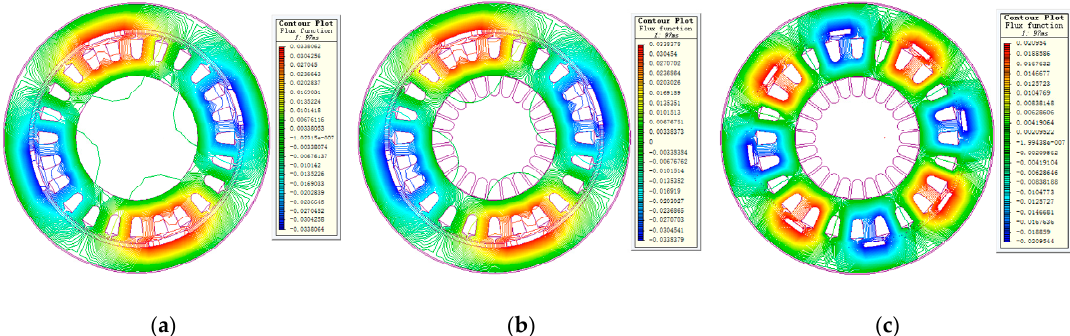
Figure 8. Magnetic flux distribution diagrams of the three kinds of motors under no load: ( a ) T-PMSM; ( b ) T-TWPMSM; ( c ) N-TWDDPMSM.